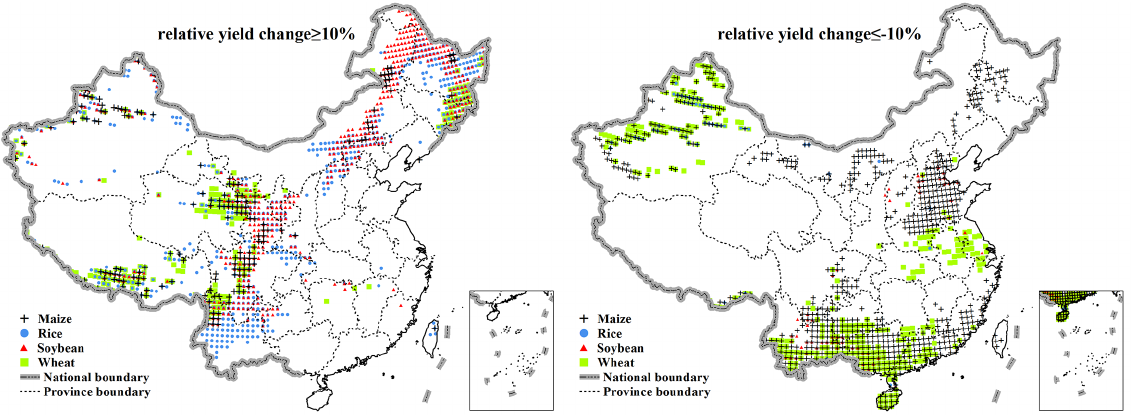
Figure 9. The high-climate-resilience areas (left column) and high-climate-risk areas (right column) for the major crops in China at 0.5 ◦